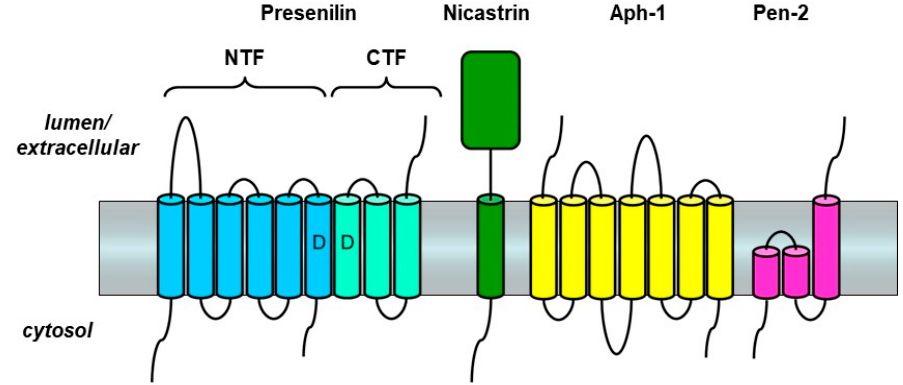
Figure 2. Presenilin and other components of the γ -secretase complex. Presenilin is a 9-TMD protein that contains two TMD aspartates (D) essential to catalysis. Assembly of presenilin with the three other components—nicastrin, Aph-1, and Pen-2—triggers autoproteolysis of presenilin into an N-terminal fragment (NTF) and C-terminal fragment (CTF) to form the active γ -secretase complex.